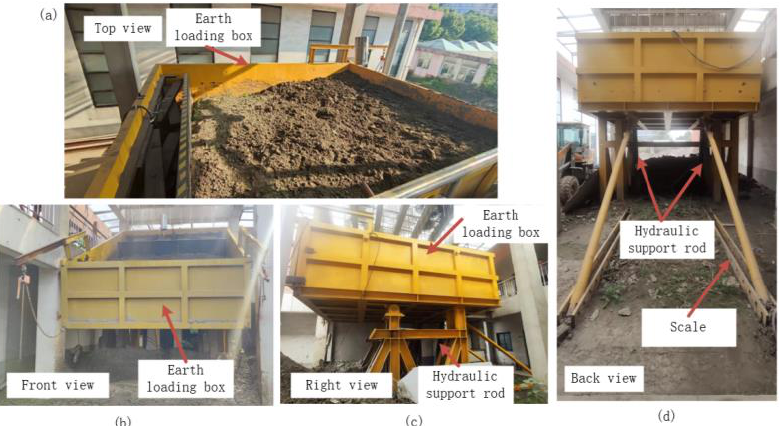
Figure 2. Details of the geotechnical disaster simulator box ( a ) Top view of the earth loading box ( b ) Front view of the box ( c ) Right view of the earth loading box ( d ) Back view of the earth loading box Rainfall-induced landslides are the most common type of landslide. Rainfall destabilizes slopes by changing the physical properties of the slope as well as the groundwater level to reduce the shear strength of the soil. The whole device is designed to simulate continuous rainfall on the slope from several hours to tens of hours.